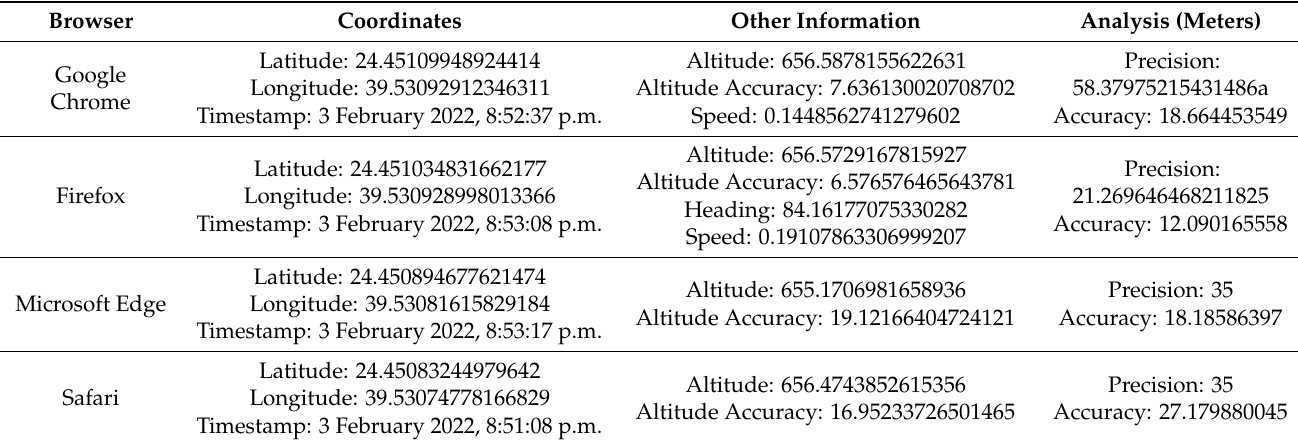
Table 7. Result and Comparison of W3C Geolocation API in iPhone by a wireless network